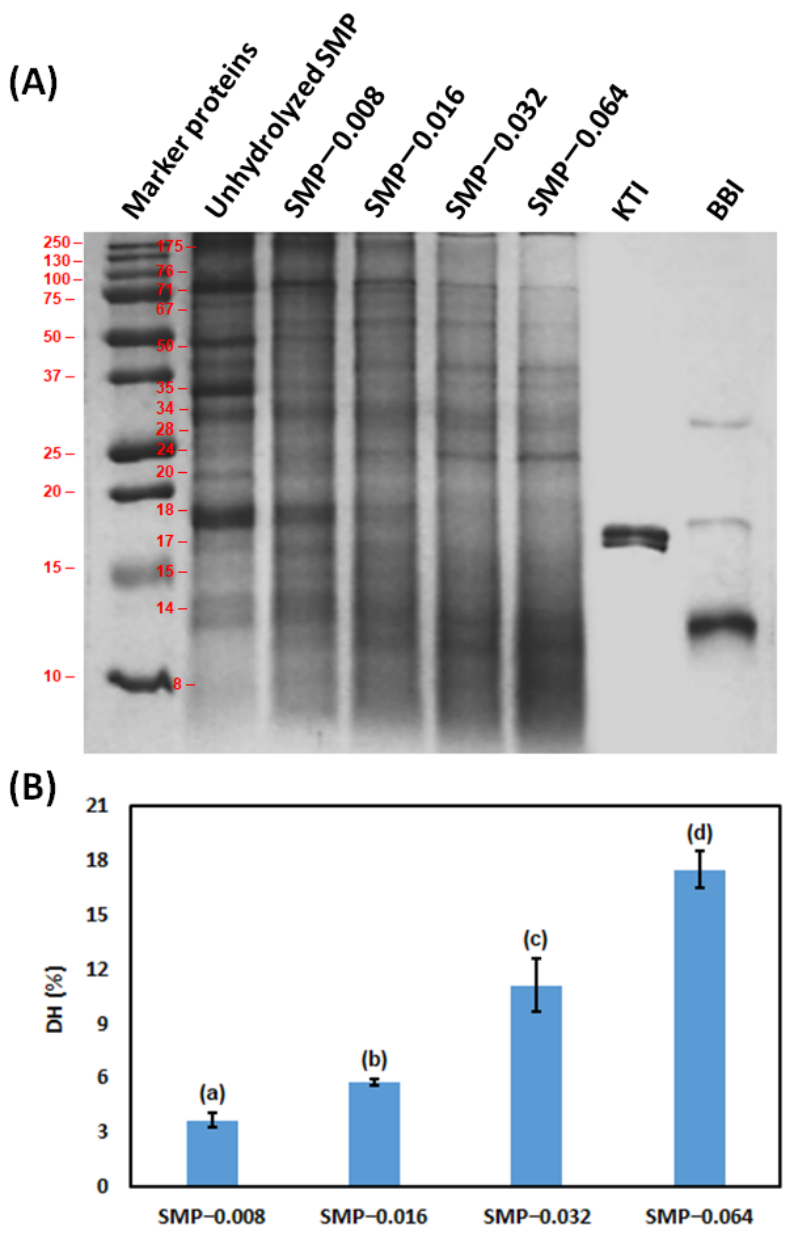
Figure 1. Image of SDS-PAGE of unhydrolyzed SMP papain-hydrolyzed SMP ( A ); DH of SMP using different concentrations of papain ( B ). The dissimilar alphabet in superscript represents the significant difference between results, evaluated by the Tukey’s post hoc method.